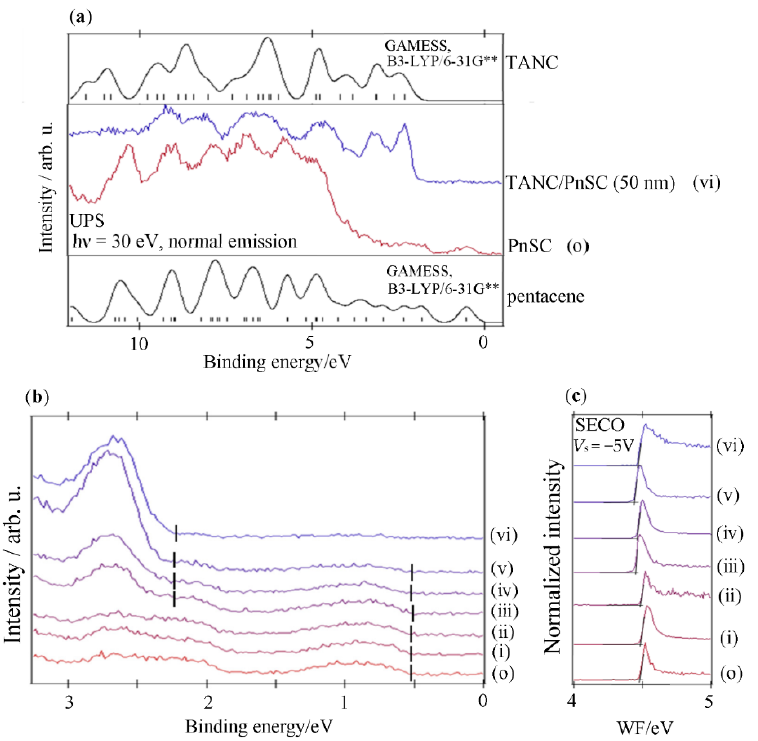
Figure 5. Evolution of the UPS spectra in the ( a ) wide, ( b ) valence band, and ( c ) secondary electron regions of the TANC/PnSC interfaces with increasing nominal TANC thickness as (o) 0, ( ⅰ ) 1, ( ⅱ ) 2, ( ⅲ ) 5, ( ⅳ ) 10, ( ⅴ ) 20, and ( ⅵ ) 50 nm. The DOS simulation curves obtained from the DFT calculation (GAMESS with B3LYP/6-31G** basis set) are also displayed in ( a ).